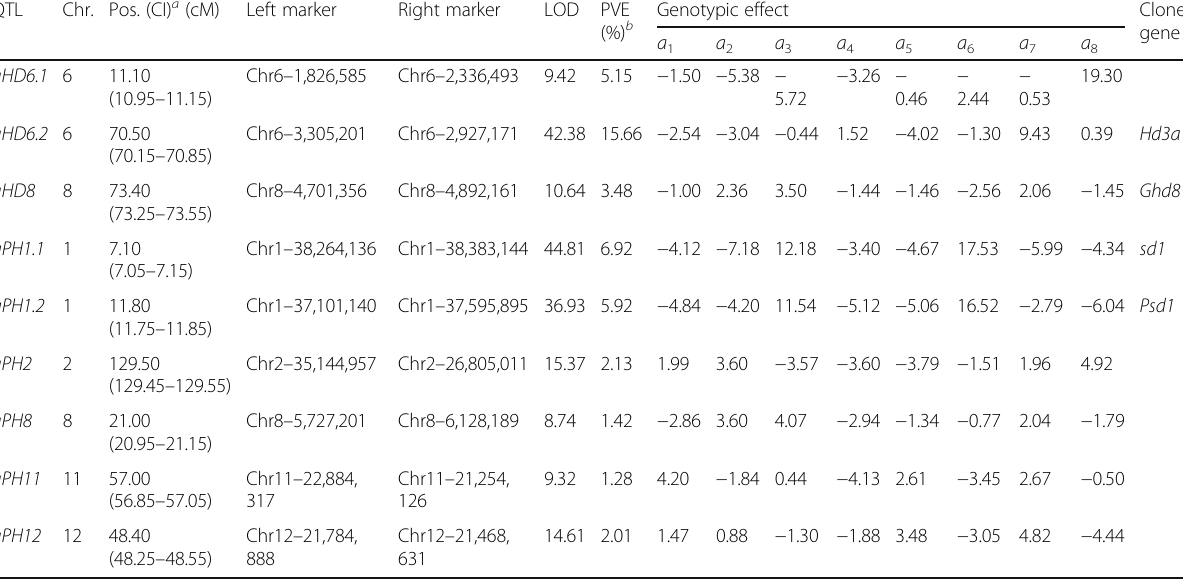
Table 3 QTLs for heading date and plant height in the eight-way-cross RIL population QTL Chr. Pos. (CI) a (cM) Left marker Right marker LOD PVE